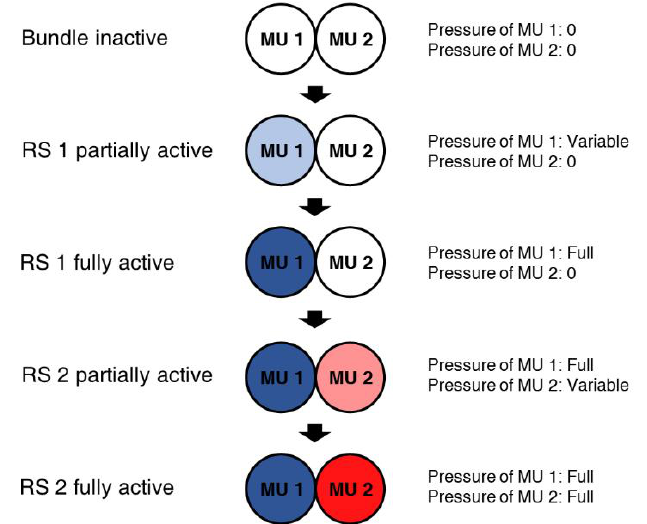
Figure 8. Orderly recruitment activation scheme for a bundle with two recruitment states (RS), denoted as RS 1 and RS 2. The bundle is in RS 1 when only the first motor unit (MU) is active. The bundle is in RS 2 when both MU 1 and MU 2 are active.